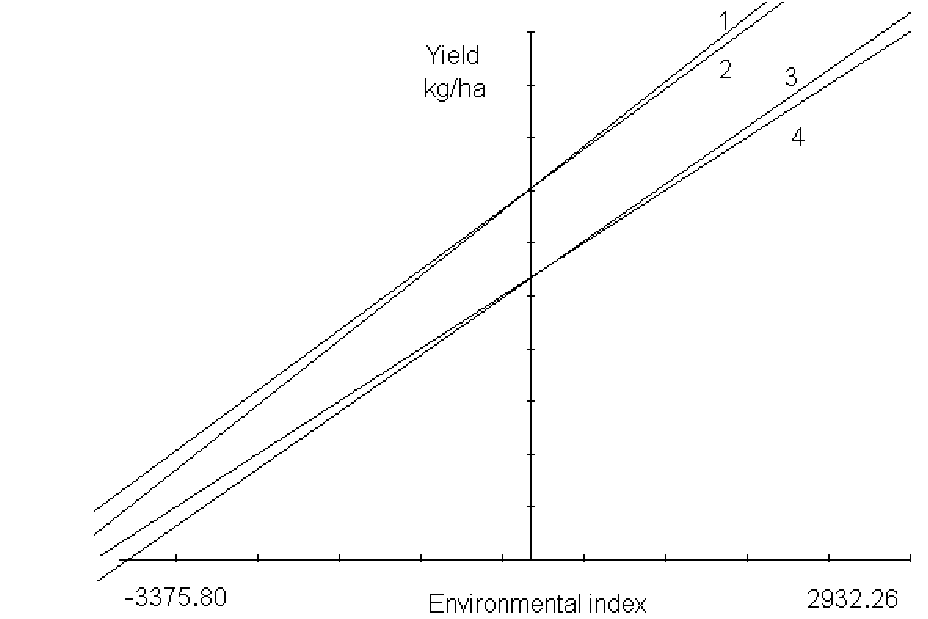
Figure 1 - Simple linear regression for adaptability of the BR-105 population to the 10 assessed environments. Estimate of m + 2g (straight line 1, with b = 1.2263), according to Eberhart and Russell (1966) and its partitioning using Griffing’s (1956) genetic effects: m + 2g 1 (line 2, b